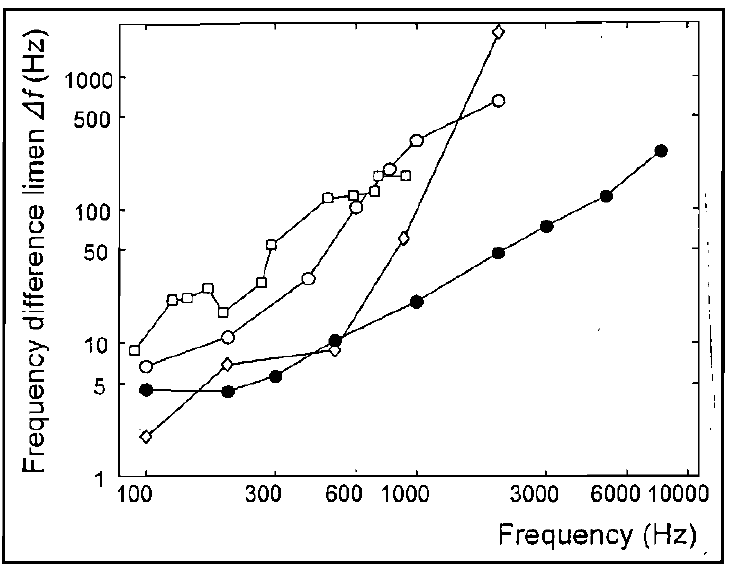
FIGURE 3. Values of the frequency difference limen Δf are plotted as a function of the frequency of electrical stimulation., on logarithmic axes. Filled circles are model predictions for electrical stimulation. Open circles and open diamonds are perceptual frequency discrimination data from two studies (for sinusoidal electrical stimulation) as reported in Pfingst (1988). Open squares are data for pulsatile electrical stimulation (Townshend et al.,